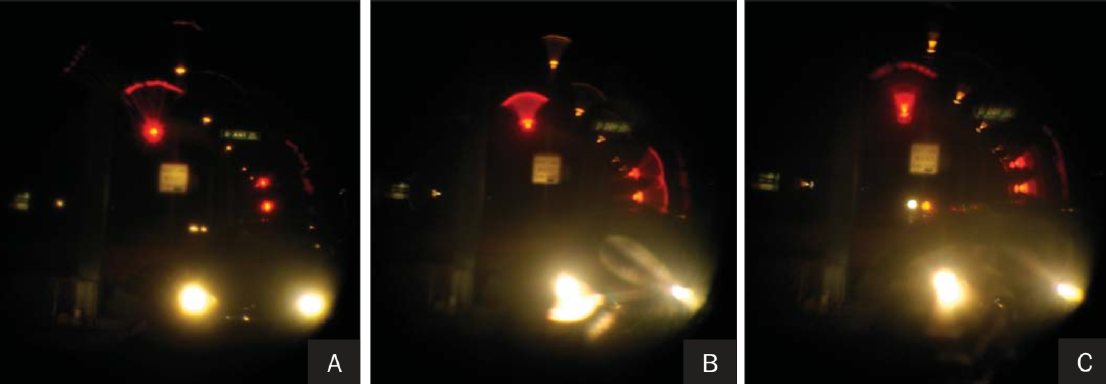
Figure 9. Night driving scene through three different multifocal IOLs, imaged through the eye model presented by Choi at al.: ( A ) ReSTOR, ( B ) ReZoom, and ( C ) Tecnis ZM900 multifocal IOLs. Journal of Refractive Surgery 2008;24(3):218–222 ([26]). Originally published by and reprinted with permission from SLACK Incorporated.